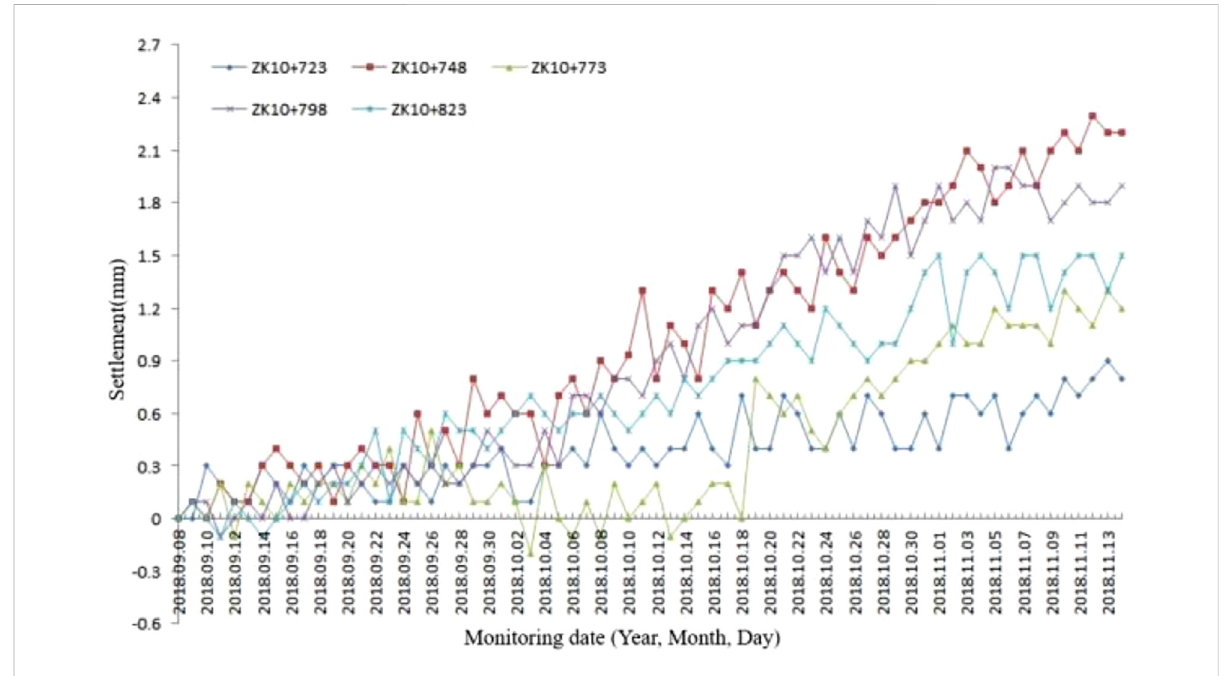
FIGURE 10 Settlement of each cross section of the on-site vault.